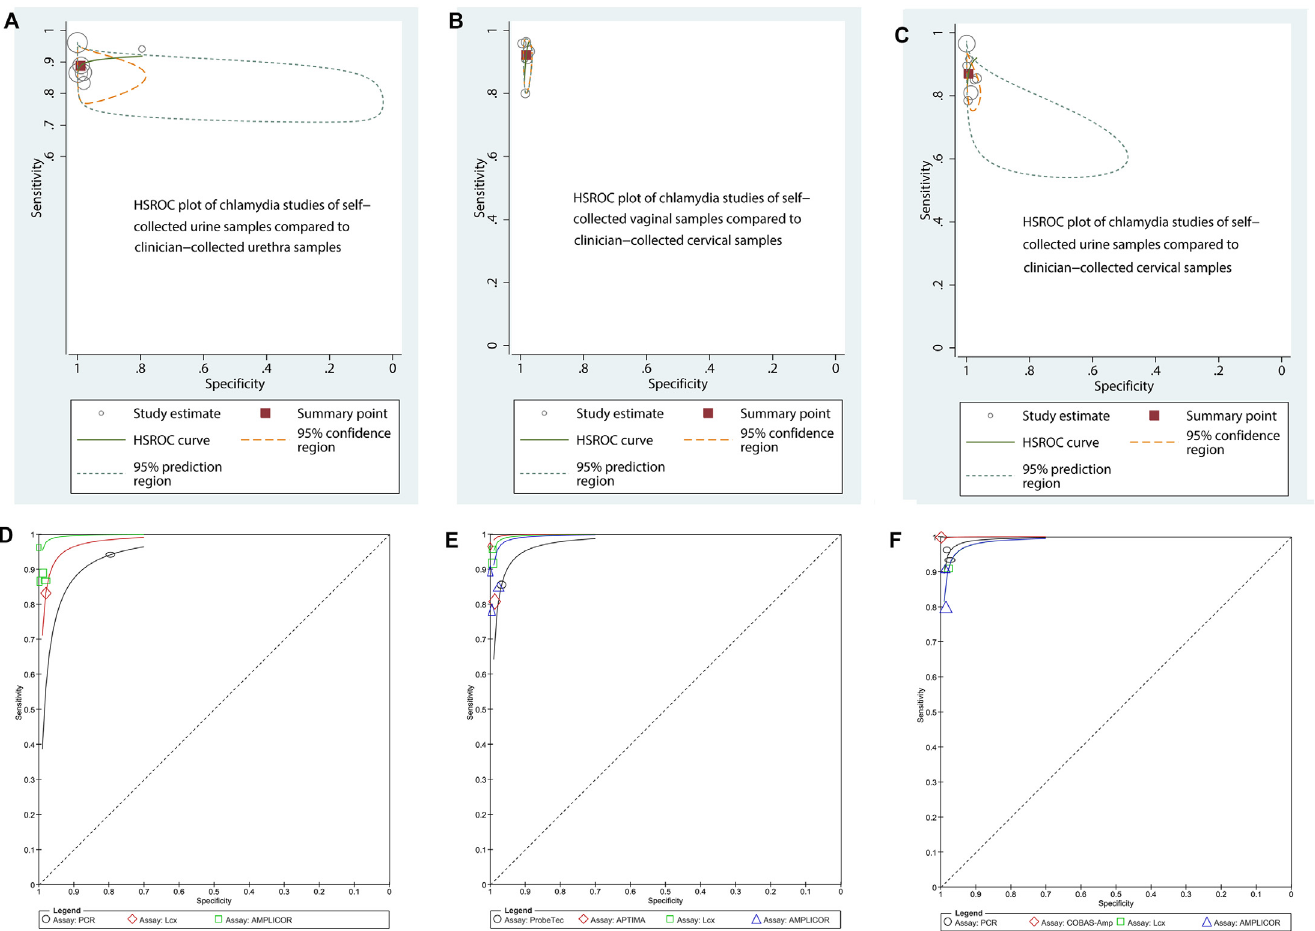
Fig 2. HSROC plots of chlamydia self-collection compared to clinician-collection (top row) and HSROC plots of chlamydia self-sampling by assay type (bottom row). Top row: The circles represent individual studies and size of the circle is proportional to the number of patients included in the study. The red square is the summary estimate of sensitivity and specificity, and the red dotted ellipse around the spots respresents the 95% confidence interval around the summary estimate. The green dotted ellipse around the spots represents the prediction contours outlining the prediction region for the true sensitivity and specificity in a future study. Bottom row: Coloured lines represent the HSROC curve by assay type in Chlamydia studies.